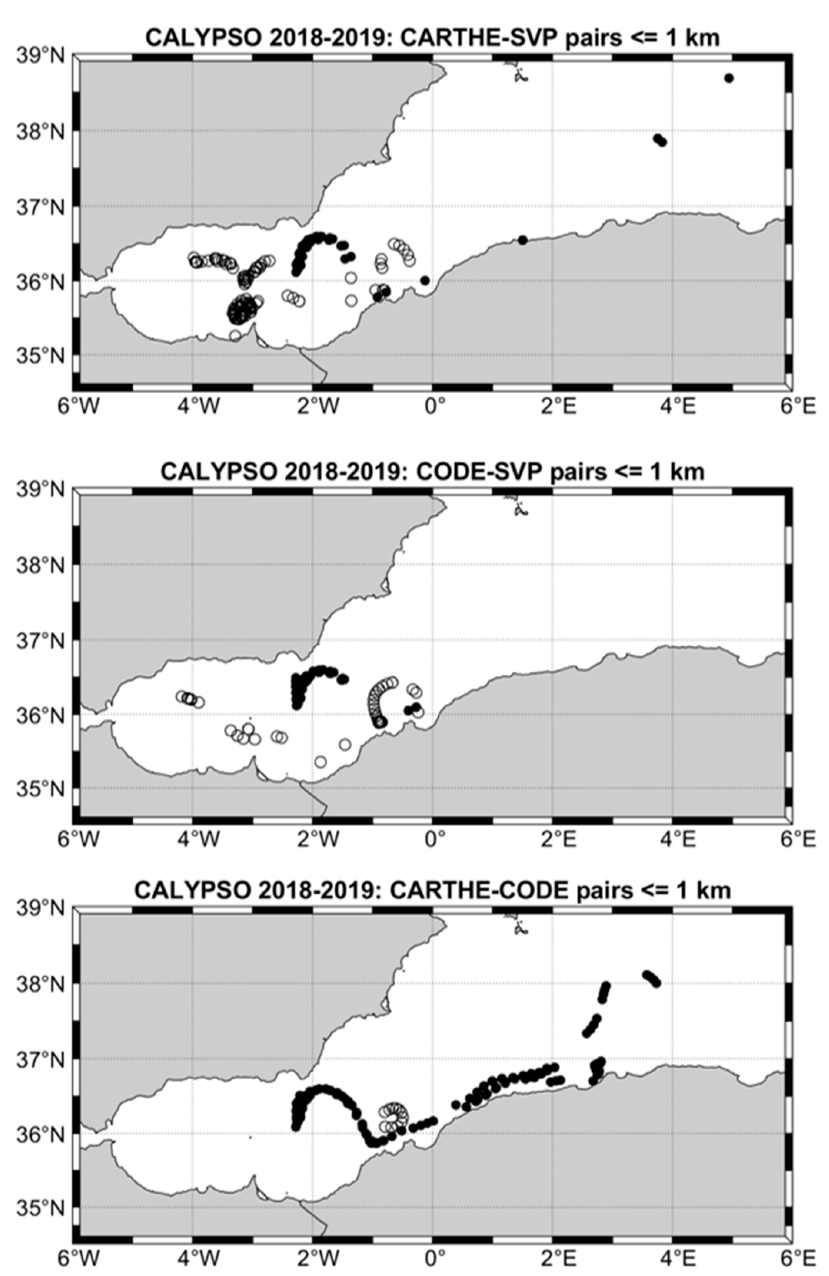
Figure 1. Locations of the CARTHE–SVP, CODE–SVP and CARTHE–CODE drifter pairs with separation distance less than 1 km: CALYPSO 2018 (black dots) and CALYPSO 2019 (circles).